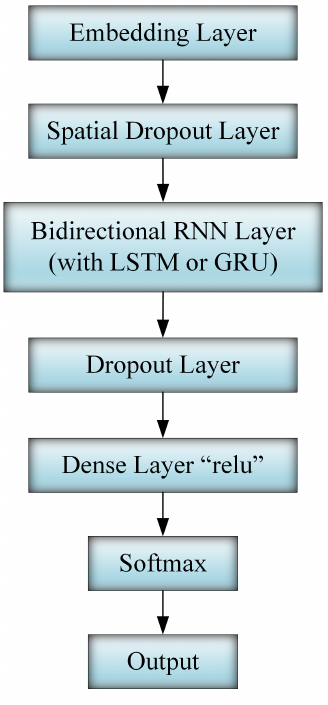
Figure 3. Full deep neural network